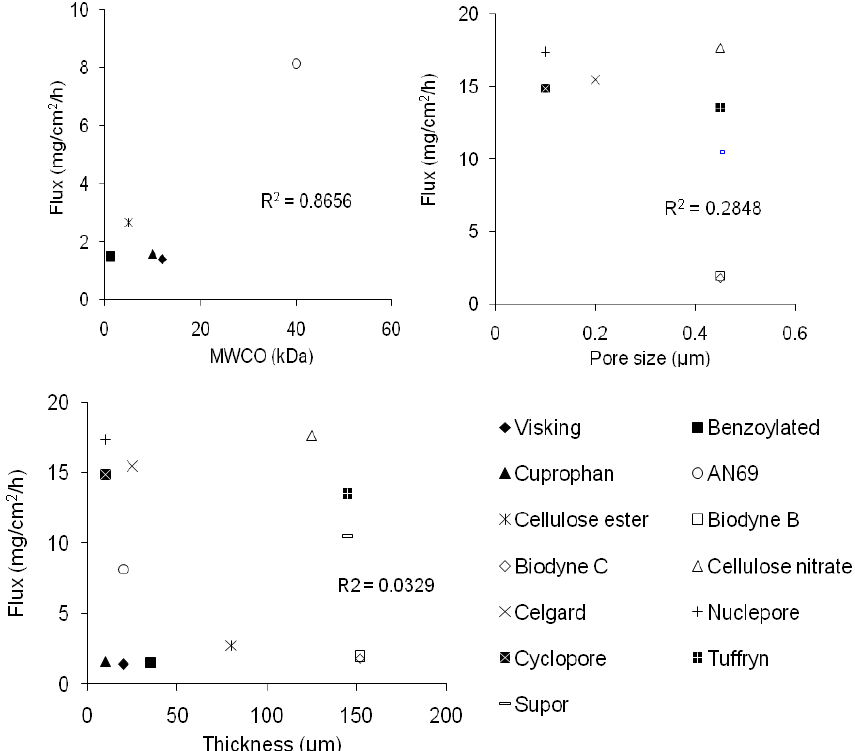
Figure 2. Correlation between ibuprofen flux and membrane molecular weight cut-off (MWCO), pore size and membrane